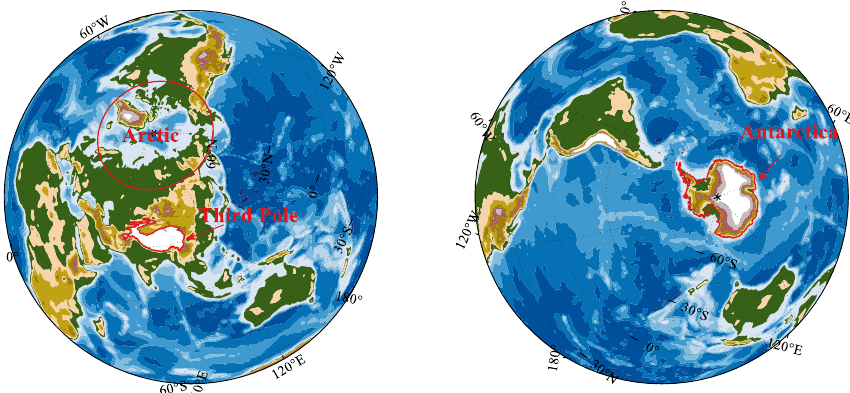
Figure 1. The locations of the Earth’s three poles. The map was drawn in the software MATLAB R2018b (https:// ww2. mathw orks. cn/ produ cts/ matlab.